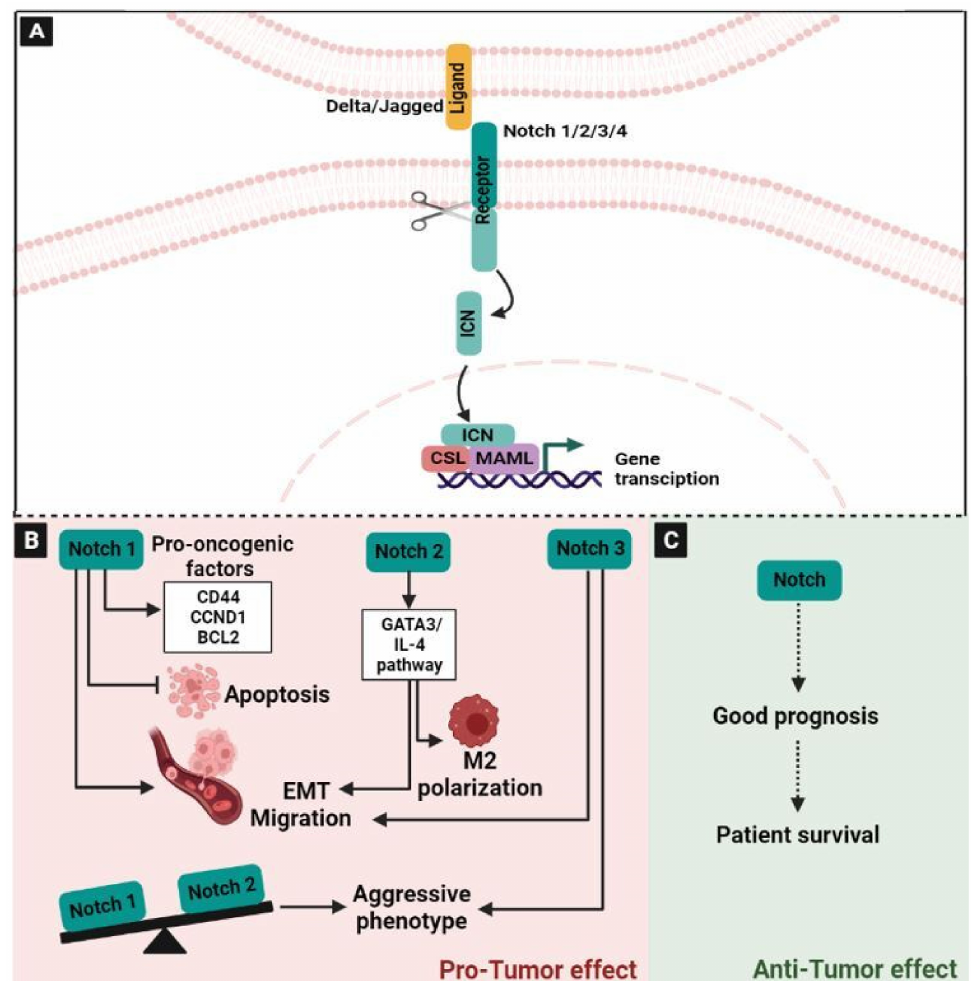
Figure 3. The NOTCH signaling pathway in colorectal cancer. ( A ) Schematic representation of acti- vated NOTCH pathway: After the interaction of the ligand and the receptor, a cascade of proteolytic cleavage is started, resulting in the release of a constitutively active ICN fragment. Then, the ICN fragment is translocated to the nucleus, where it associates with CSL and MAML as part of a larger transcriptional complex. ( B ) Notch1 inhibits apoptosis and induces invasiveness and metastasis in CRC by activating several pro-oncogenic factors, such as CD44, CCND1, and the BCL2. Notch 2 activates the GATA3/IL-4 pathway, thereby promoting macrophage M2 polarization and enhancing EMT. Moreover, Notch1/2 had an opposite clinical outcome, where the increased expression of Notch1 and a reduced Notch2 were associated with poor overall survival. Notch 3 is linked to metastatic CRC and it is associated with an aggressive phenotype. ( C ) Notch2 was considered to be